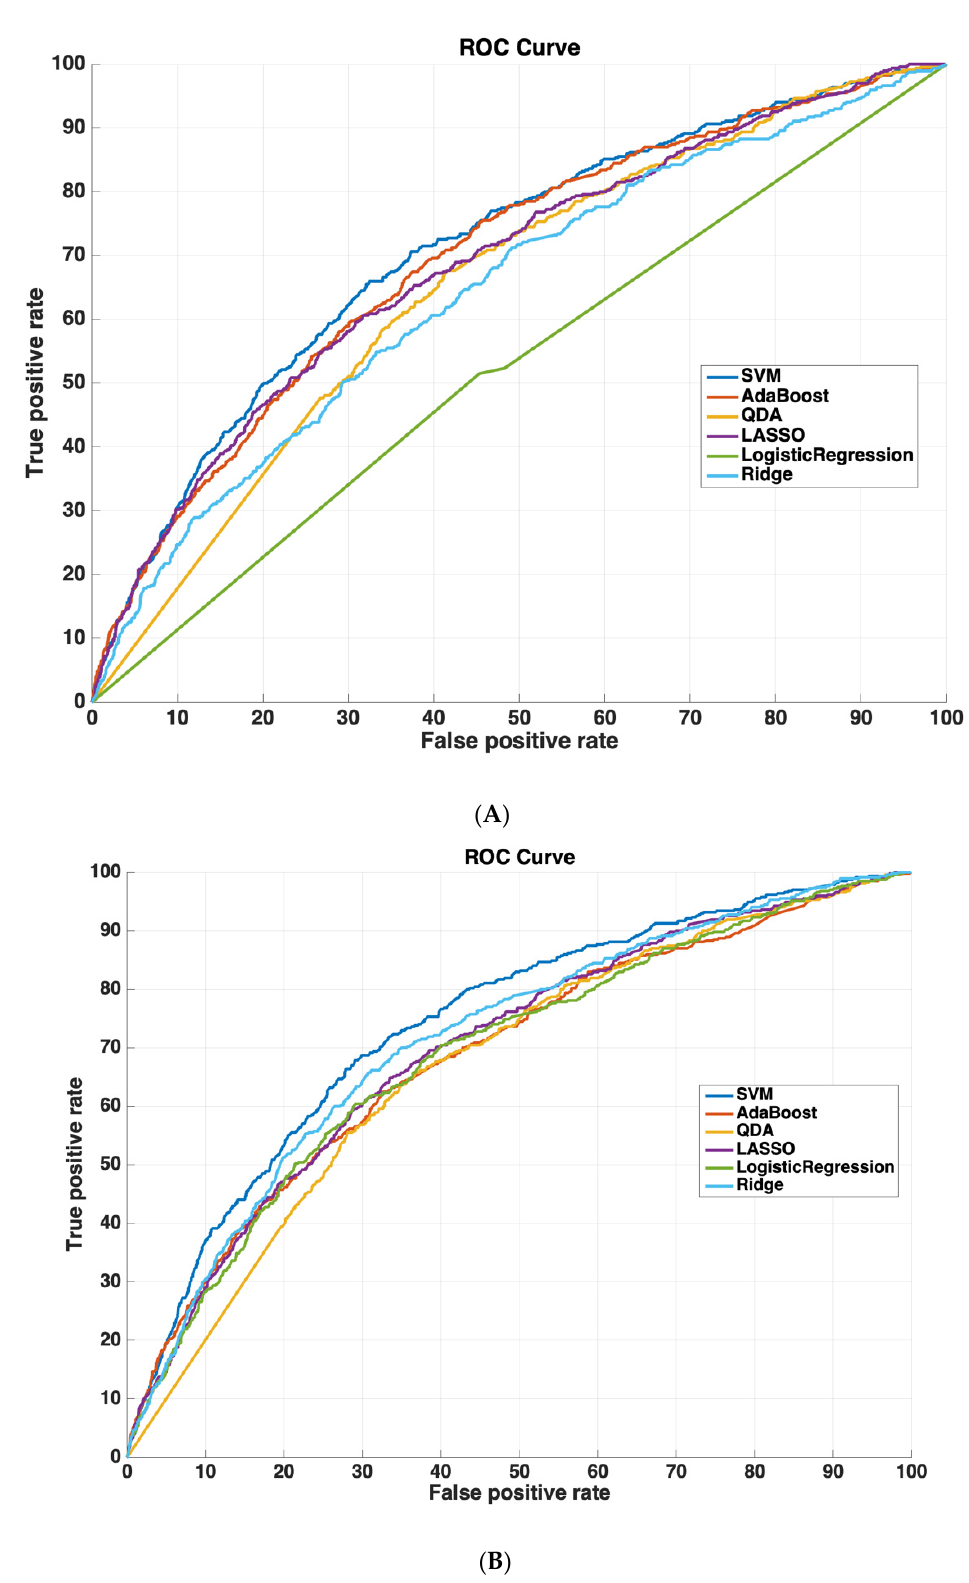
Figure 5. Receiver operating characteristic (ROC) curves compare the performance of each machine learning algorithm to predict readmission either ( A ) using all 3000 features or ( B ) using only features determined by ML (825 features). Support vector machines had the highest performance of all machine-learning algorithms.